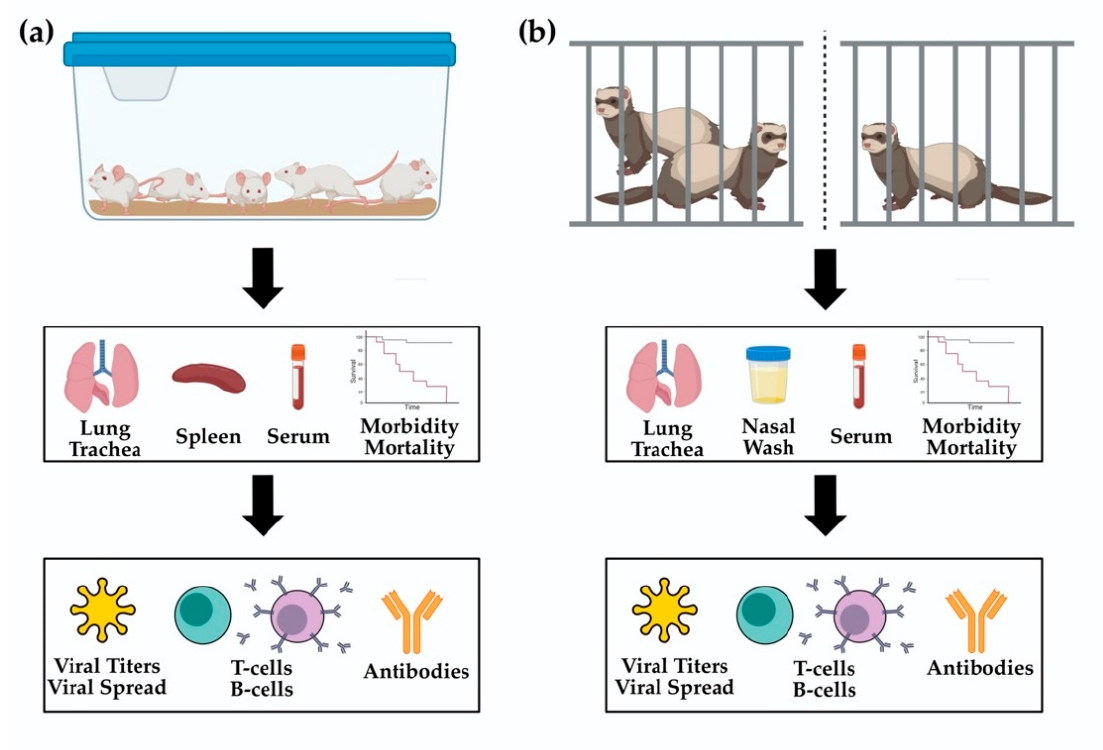
Figure 2. Experimental setups for vaccination experiments: ( a ) mouse vaccination experiments are designed so that each vaccine group is co-housed in a single cage. A maximum of five to ten mice can be placed in a single cage. Morbidity and mortality are monitored for 14 days post challenge. Sera, lungs, trachea and spleens may be collected to measure viral titers, viral spread, B-cell, T-cell and antibody responses; ( b ) ferret transmission and vaccination experimental design. For contact transmission, ferrets are co-housed with a maximum of two animals per cage. For aerosol transmission, ferrets are in two separate cages, spaced far apart enough to prevent direct contact. Airflow goes from the infected to uninfected animal. Tissues and sera are collected and utilized in a similar manner as those collected for mouse experiments. Additionally, ferret nasal wash samples or nasal swabs are collected and can be used to interrogate viral titers, innate immune responses and mucosal immunity. This figure was created with BioRender.com (accessed on 1 April 2021) and Affinity Designer v1.9.